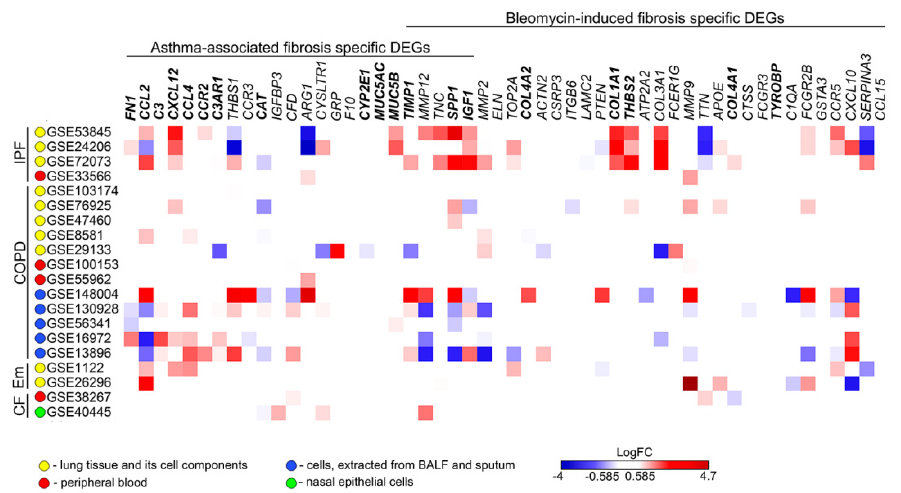
Figure 9. Expression of asthma- and bleomycin-associated pulmonary fibrosis DEGs in human chronic lung pathology. Heat map demonstrating expression levels of DEGs connected with asthma- associated and bleomycin-induced lung fibrosis in human datasets. Heat map construction was performed using Morpheus. LogFC = Log 2 (fold change). Different types of biological materials were used: lung tissues (GSE53845, GSE24206, GSE72073, GSE8581, GSE103174, GSE76925, GSE47460, and GSE1122), peripheral blood (GSE33566, GSE100153, and GSE28267), alveolar macrophages (GSE130928, GSE16972, and GSE13896), sputum (GSE148004), epithelial cells of small airways (GSE56341), total leukocytes from peripheral blood (GSE55962), alveolar epithelial cells type II (GSE29133), lung myeloid cells (GSE26296), and nasal epithelial cells (GSE40445). IPF, idiopathic pulmonary fibrosis; COPD, chronic obstructive pulmonary disease; Em, chronic emphysema; CF, cystic fibrosis. Bold font denotes genes validated in this study in the murine model of OVA − induced asthma and asthma − driven pulmonary fibrosis.